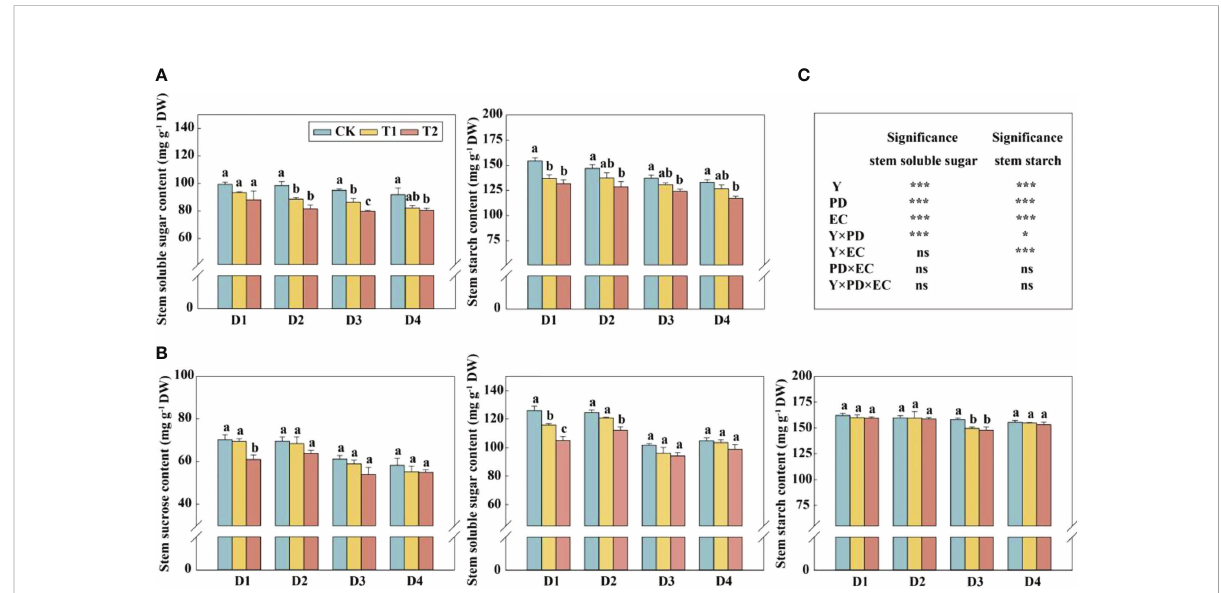
FIGURE 4 Effects of EC and PD on soluble sugar and starch in the stems of summer maize in 2020 (A) . Effects of EC and PD on sucrose, soluble sugar, and starch in the stems of summer maize in 2021 (B) . Results of ANOVA on the effects of year (Y), plant density (PD), EC treatments (EC) and their interactions on soluble sugar and starch in the stems in 2020 – 2021 are listed (C) . Different lowercase letters indicate signi fi cant differences between EC treatments at each plant density. ns means non-signi fi cant. * and *** indicate signi fi cant differences at P< 0.05 and< 0.001 probability levels, respectively. EC, plant growth regulator; PD, plant density; D1, D2, D3, and D4 indicated plant density at 4.5, 6.0, 7.5, and 9.0 plants m − 2 , respectively; CK, T1, and T2 indicated water control, 2 mL L − 1 EC (ethephon: cycocel = 3:1), 4 mL L − 1 EC,